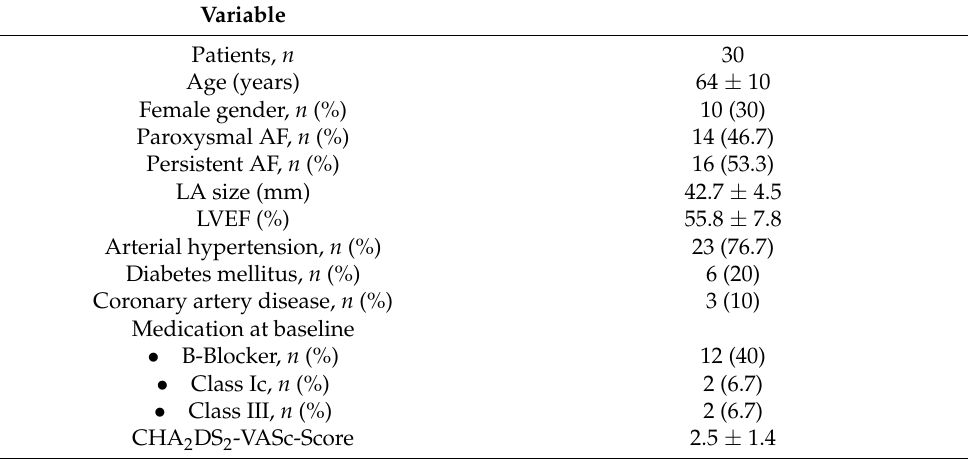
Table 1. Baseline characteristics and medication before catheter ablation. Values are expressed as n (%) or mean ± standard deviation. AF, atrial fibrillation; LA, left atrium; LVEF, left ventricular ejection fraction.